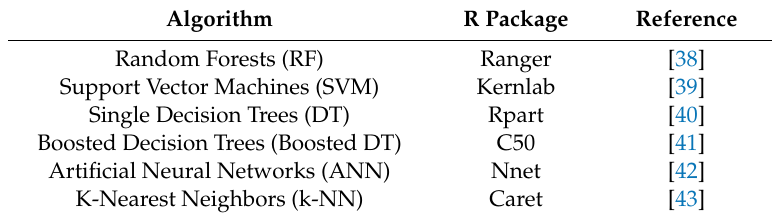
Table 5. The six algorithms for supervised classification with the related R package used and compared on the collected